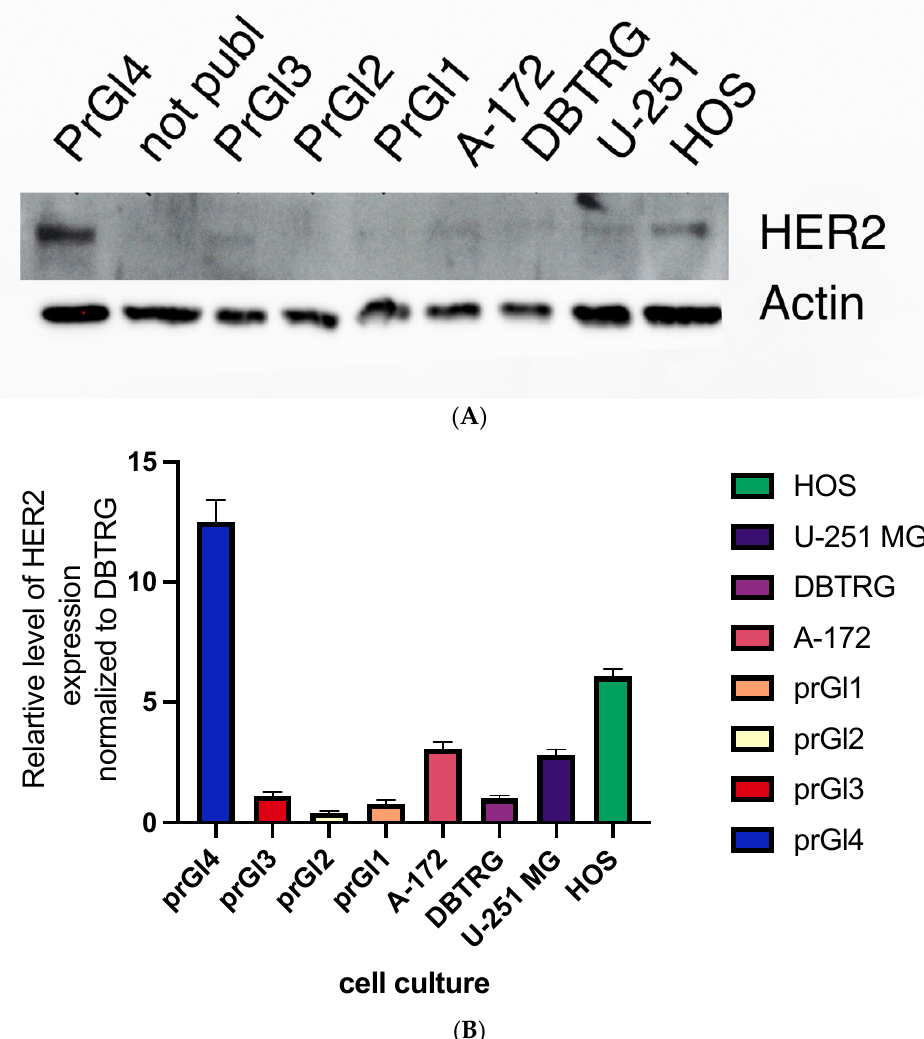
Figure 9. Western blot analysis of HOS, U-251 MG, and DBTRG-05MG cells. The latter developed a complete response to type I interferon as a protection from the subsequent VSV infection. Two other cell lines, osteosarcoma and glioma/astrocytoma, were not completely protected from the virus by interferon treatment. Membranes were incubated with antibodies against HER2 and β -actin for standardization ( A ). The relative ratio of protein expression of β -actin-standardized HER2 levels compared to DBTRG-05MG cells ( B ). Uncropped Western blot scan can be found in Supplementary Materials in Figure S1.